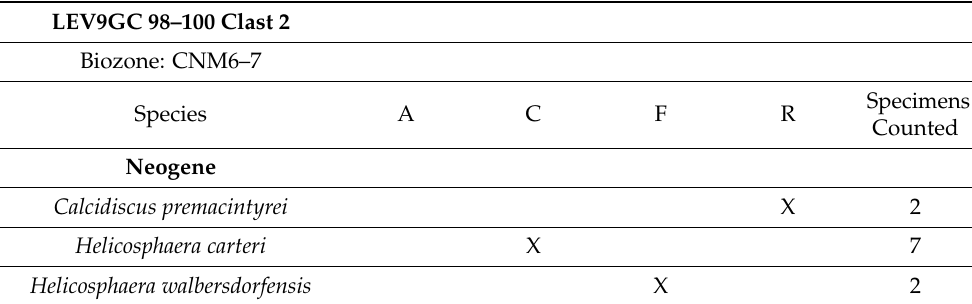
Table A42. Leipzig